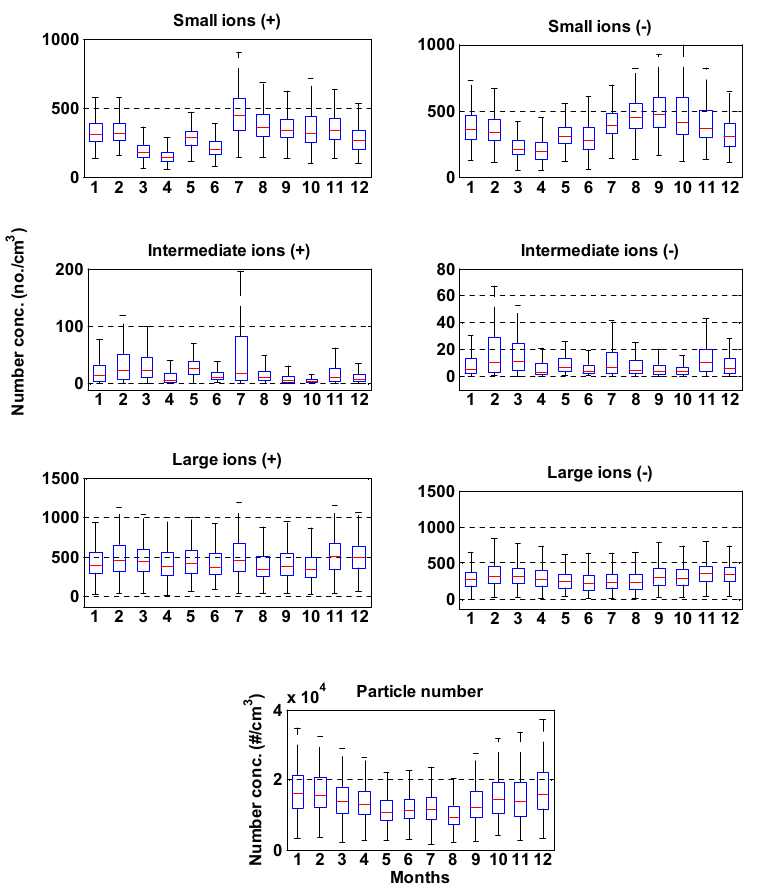
Figure A4. Monthly variations of ions and particles in Paris. The edges of the boxes represent 25th and 75th percentiles, the central line is the median, the whiskers represent the highest concentrations (not considered outliers). The data span the period 1 July 2009–30 September